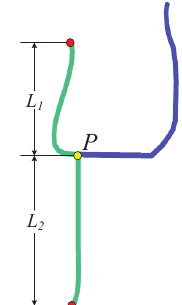
Figure 11. P (yellow circle) is the intersection of two roads (green and blue). L 1 and L 2 denote the lengths of two parts of one road (green) separated at P